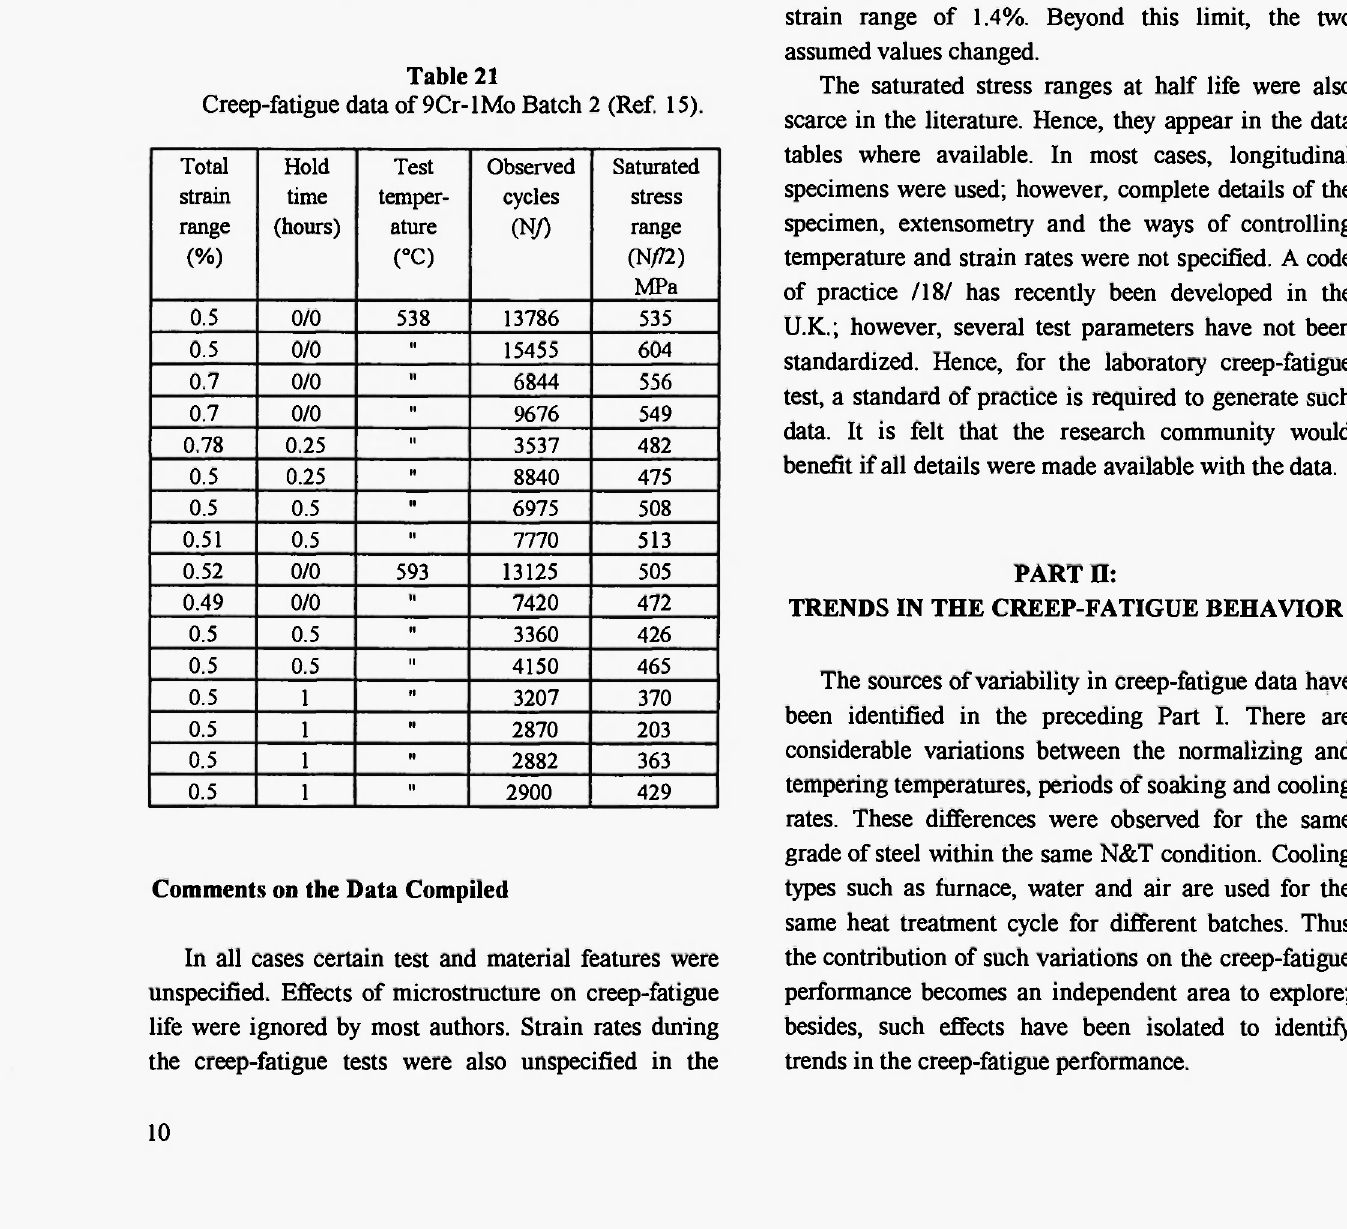
Creep-fatigue data of 9Cr-lMo Batch 2 (Ref.